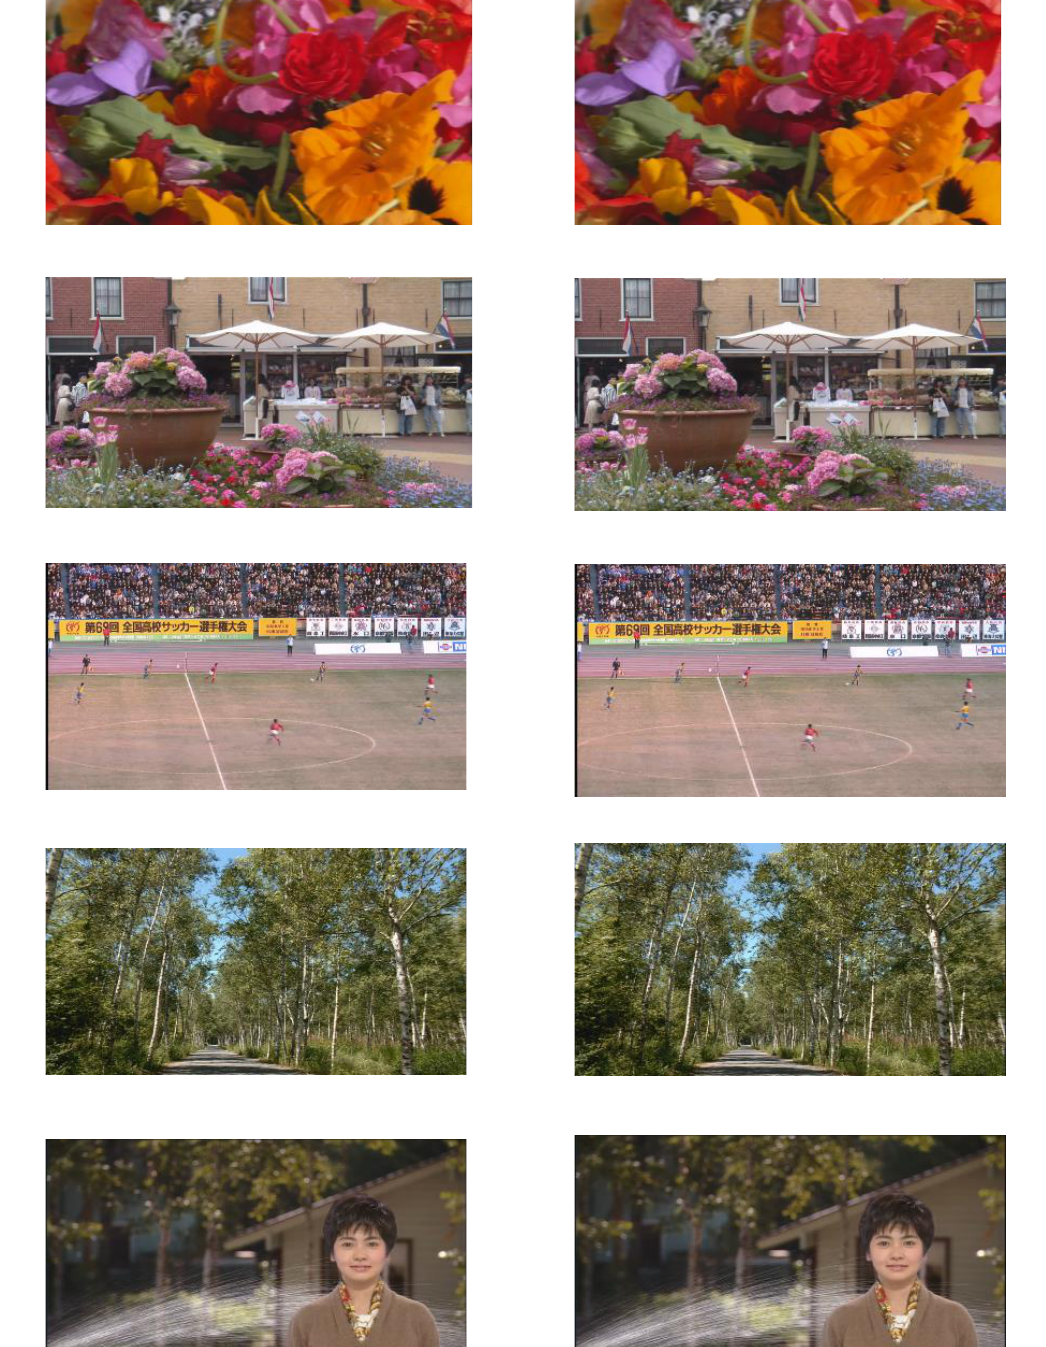
Figure 6. ( Left ) Compressed original frames based on H.264, and ( Right ) watermarked frames from evaluation Set-4 ( α = 0.4, SSIM 0.9945, PSNR 44.03